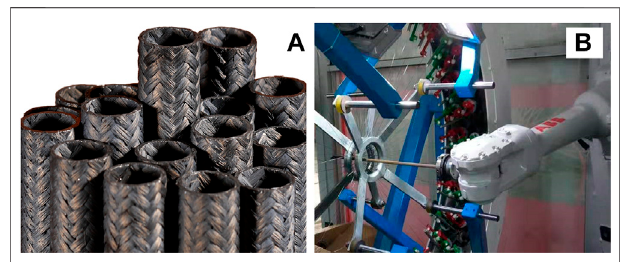
FIGURE 1 | The 2D braiding technique for nuclear claddings. (A) The ceramic cladding based on 2D braided preform. (B) The six axis robot aided braiding